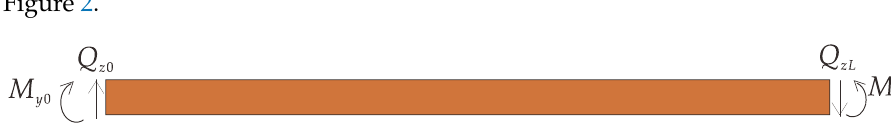
Figure 2. Schematic diagram of piezoelectric cantilever beam boundary force. The influence of temperature and residual stress on the piezoelectric cantilever beam is not considered in the modeling. According to the Hamilton principle, the governing equation of the harvester can be written as